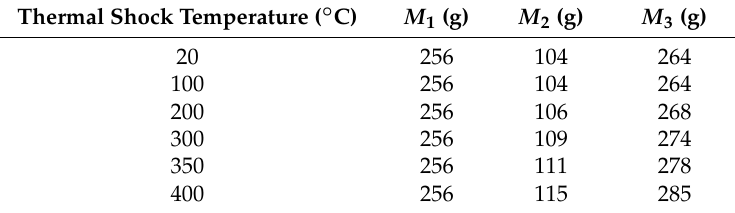
Table 2. The measured results of the Archimedes drainage method.